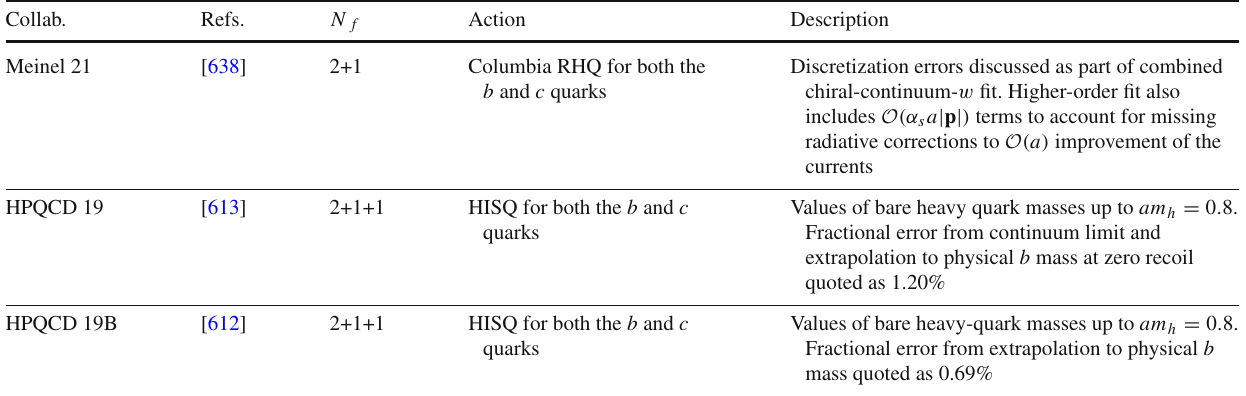
(cid:6)ν and (cid:8) → (cid:8) ( ∗ ) (cid:6) ¯ ν form factors, and of R ( D ( b c s )